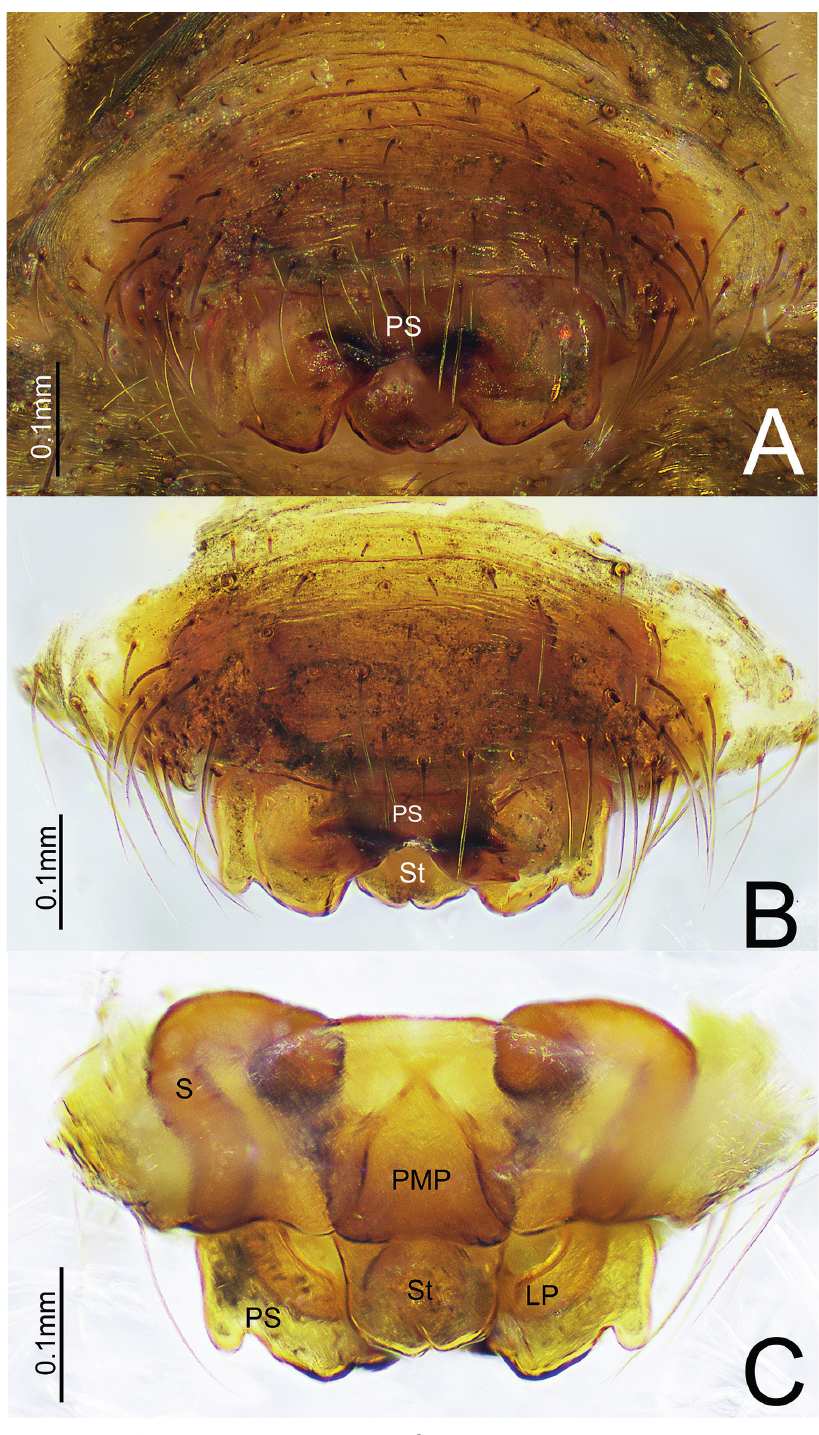
Figure 8. Himalaphantes uncatus sp. nov., paratype ♀ A, B epigyne, ventral view C epigyne, dorsal